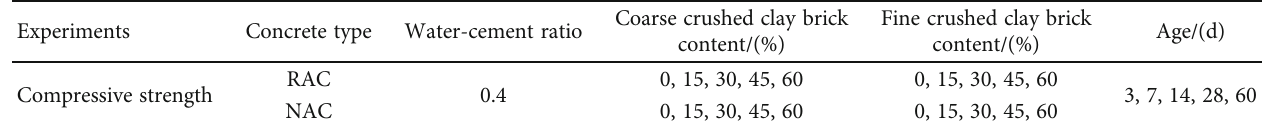
Table 5: Compressive strength test scheme.